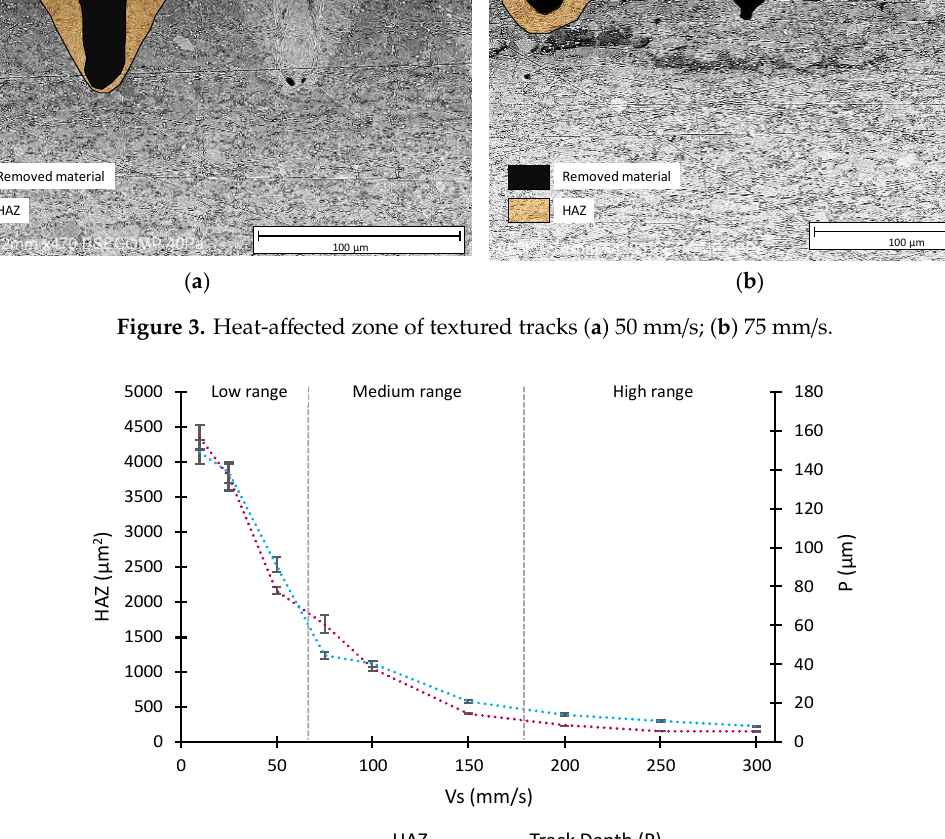
Figure 5. Microstructural and composition changes induced by laser treatment (V s = 50 mm/s).